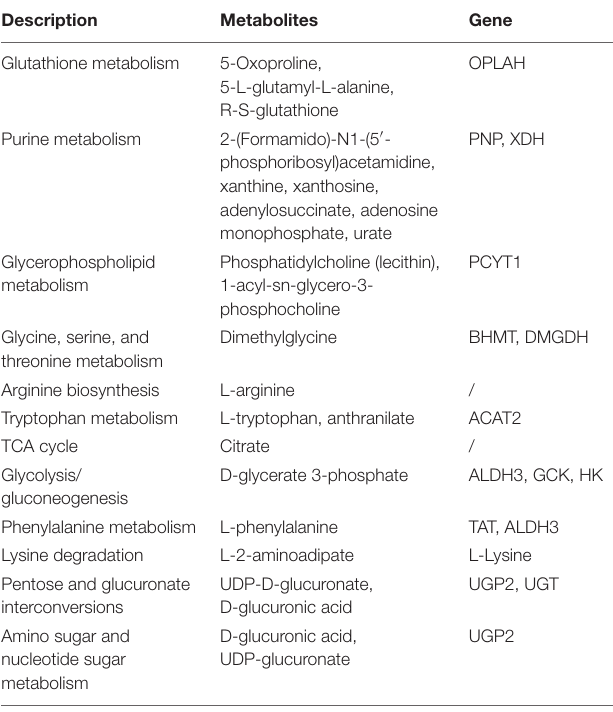
TABLE 3 | Shared DMs and DEGs in the KEGG pathway of O. mykiss which fed diets with replacement of FM and/or FO.